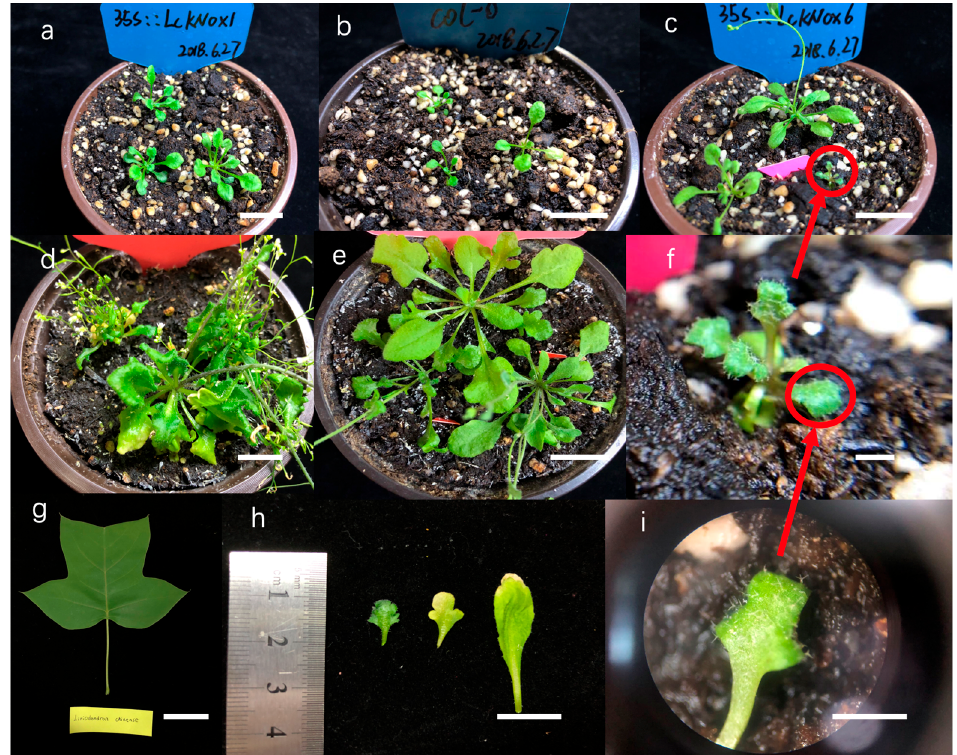
Figure 2. The wild type (WT) and transgenic 35S::LcKNOX Arabidopsis thaliana and Liriodendron